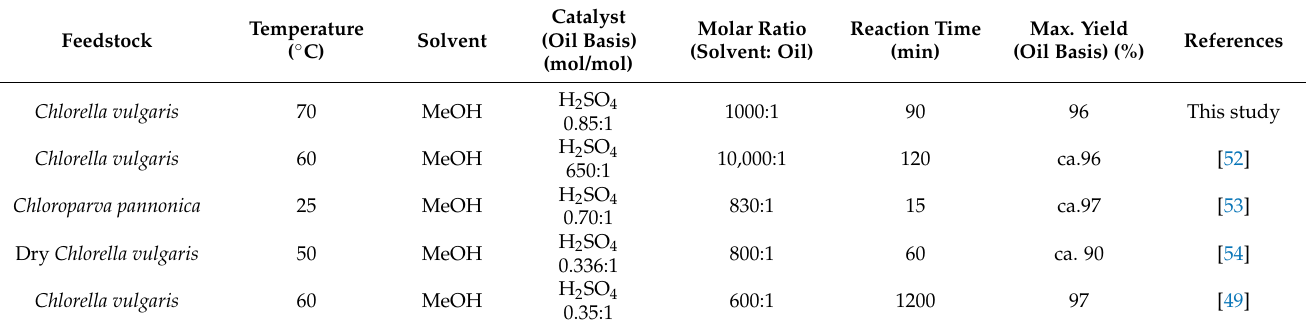
Table 1. Comparison of the present study with